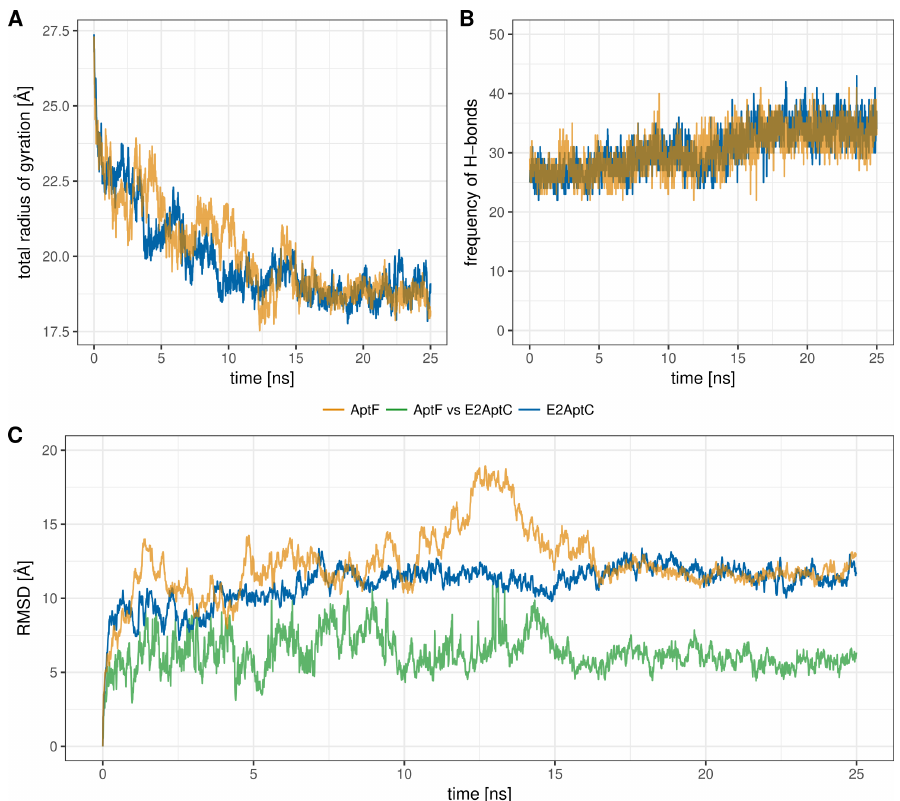
Figure 3. Different structure stability analyses versus time plots during the 25 ns MD simulation for AptF (orange line) and E2AptC (blue line): ( A ) radius of gyration; ( B ) number of H-bonds within the aptamer structure; and ( C ) structural deviation (RMSD calculation) over the course of MD simulation with respect to the starting structures of AptF and E2AptC. The green line shows the structural deviation between AptF and E2AptC from the respective time step. AptF, aptamer-free; E2AptC, E2-aptamer complex; RMSD, root mean square